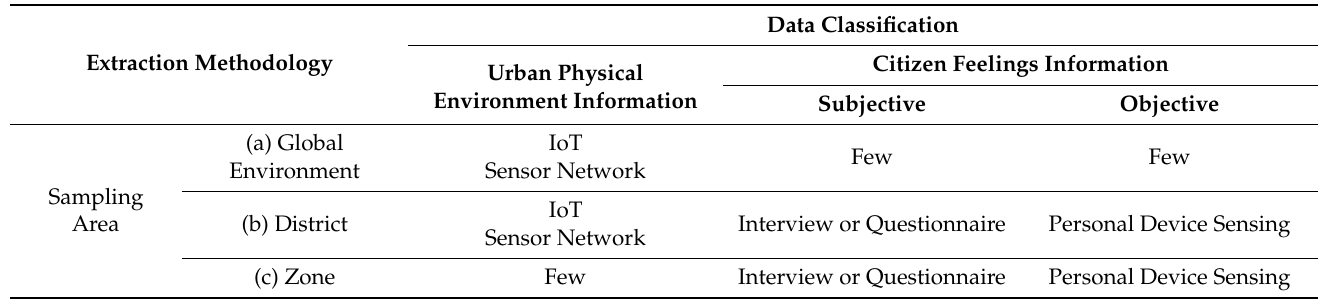
Table 1. Rules for classifying citizen feelings into calculable data. It shows the process of data quan- tification, because the data formats of environmental problems are totally different from one